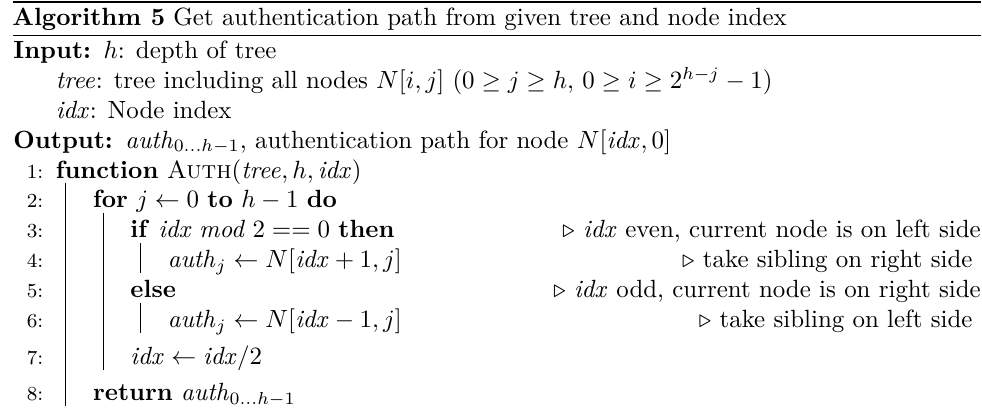
Algorithm 5 Get authentication path from given tree and node